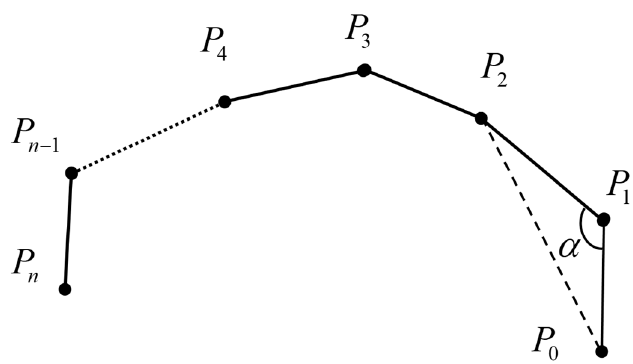
Figure 2. Diagram of angle method.